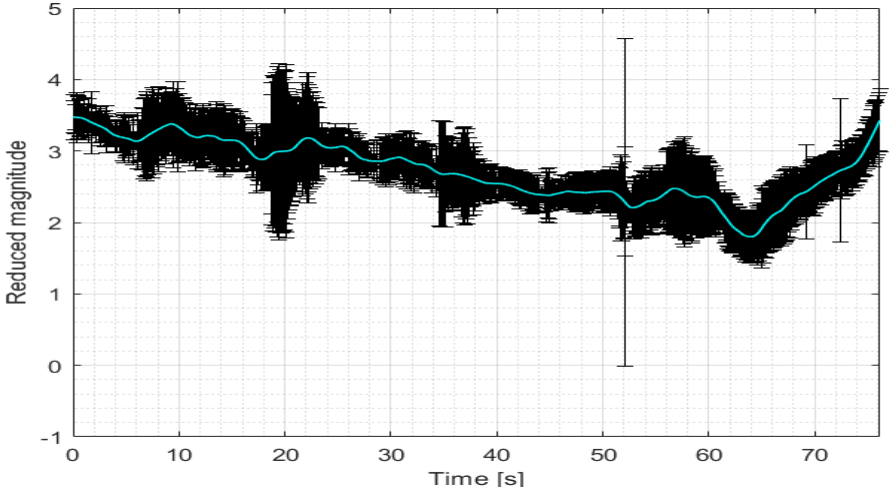
Figure 12. Observed light-curve of ATLAS 2AS CENTAUR (SSN 28096) taken the 30/10/2020 from RESDOS observatory.